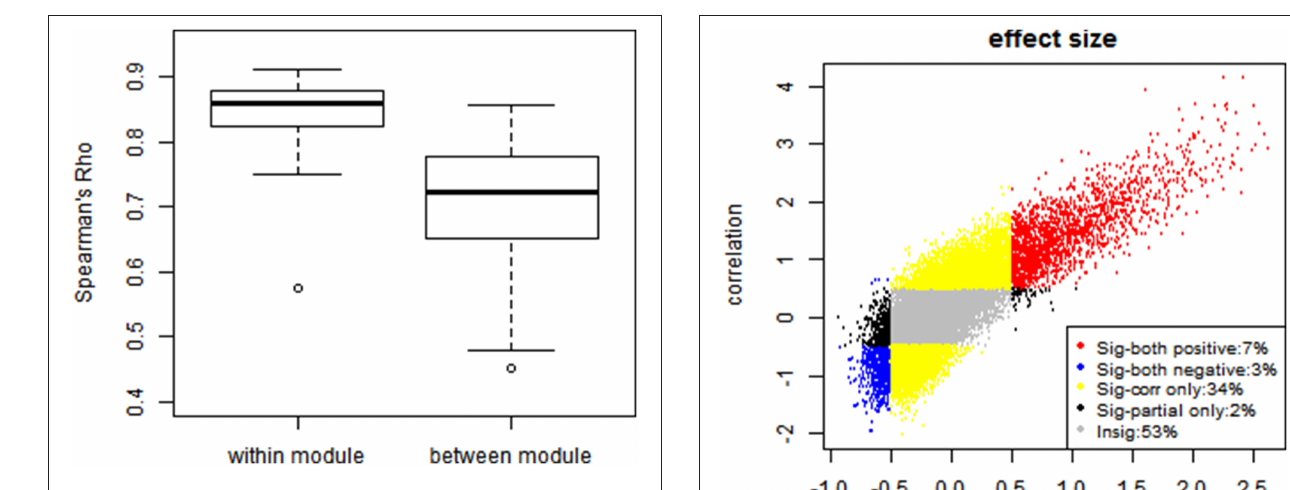
FIGURE 8 | Modulewise Spearman’s rank correlation between partial correlation and full correlation. We calculated Spearman’s rank correlation between partial correlation and full correlation within each of the 55 functional module pairs ( Smith et al., 2009), where the Spearman’s rank correlation FIGURE 9 | Effect size-based analysis. Each edge is classified into four between the full correlation and partial correlation for within-module edges categories based on its effect size under partial correlation and full correlation, [Mean(SD) 0.825(0.098)] was significantly higher than those [Mean(SD) = = where the significant threshold for absolute effect size is set to be 0.702(0.103)] for between-module edges ( p 0.003 ). =